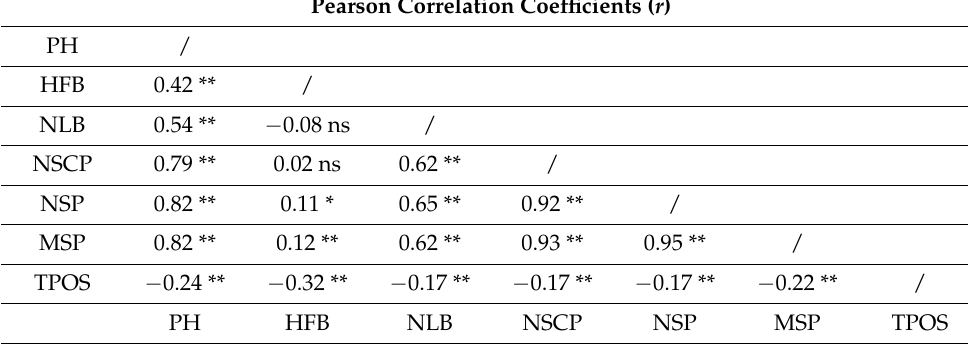
Table 5. Pearson correlation coefficient ( r ) between yield-related traits for all trials conducted during